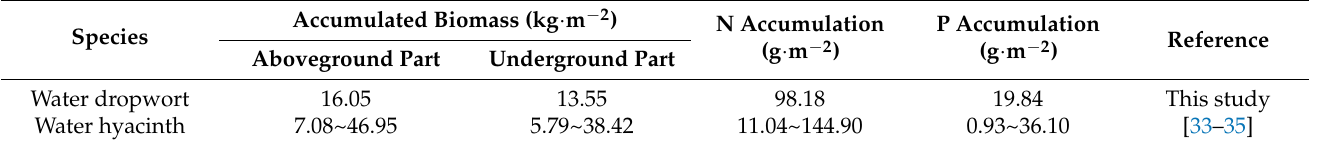
Table 2. Comparison of N and P accumulation of water dropwort and water hyacinth.